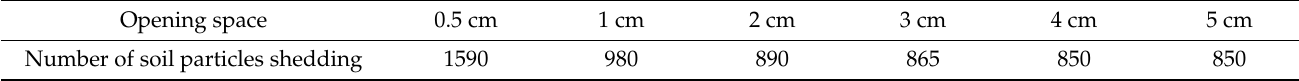
Table 3. The number of soil particles shedding in different opening space.